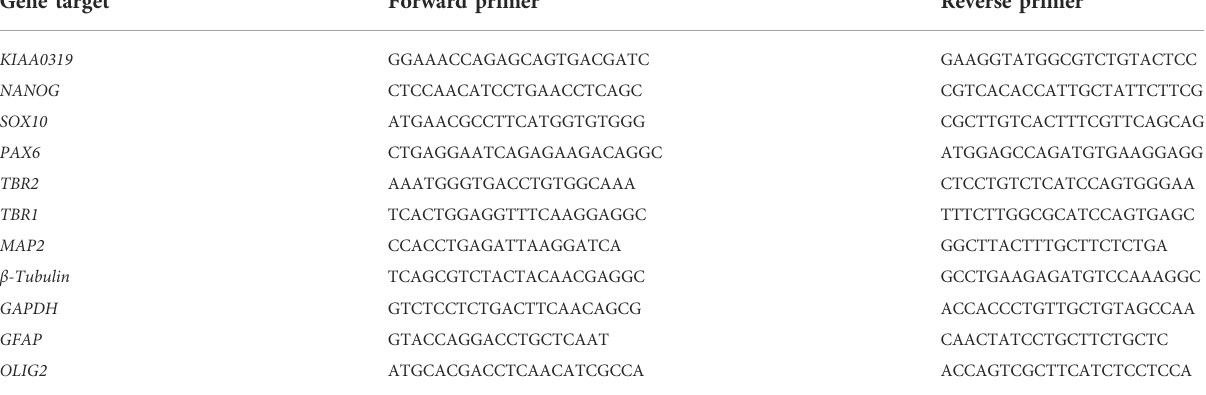
TABLE 2 qRT-PCR gene target